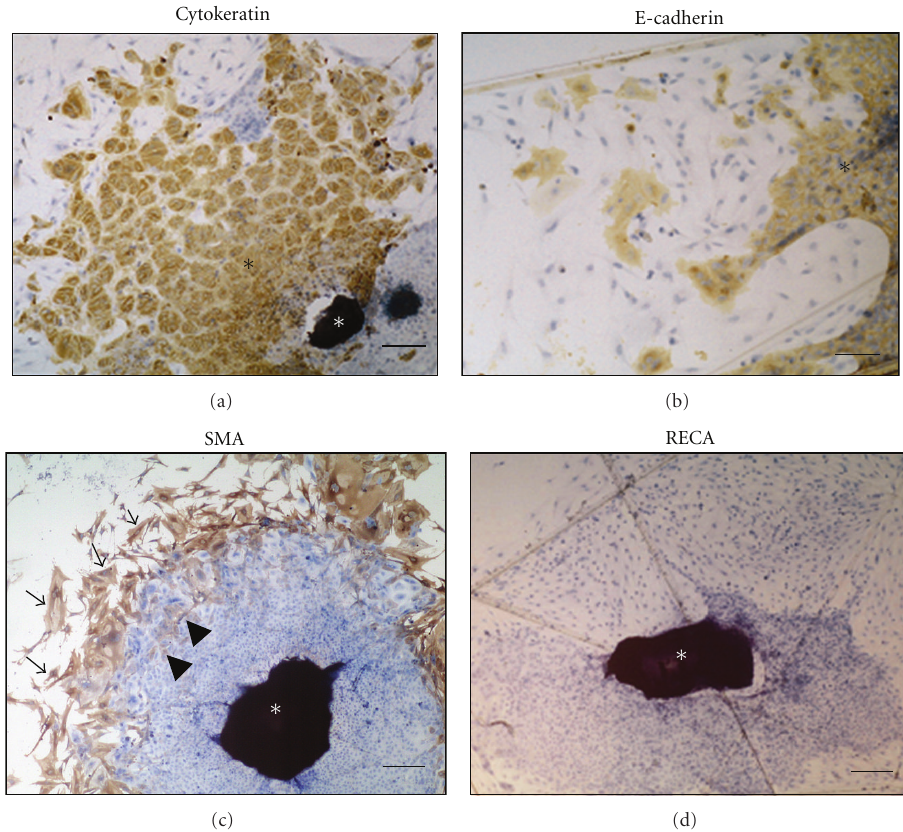
Figure 2: Immunohistochemical staining characteristics of cells 10 days after explanting. Two distinct areas are seen—an inner most area of cuboidal-shaped cells staining for (a) cytokeratin and (b) E-cadherin (black asterisk) and stellate-shaped cells at the periphery staining for (c) the myofibroblast marker SMA. Occasional cells at the junction of the two areas stain for SMA (arrow heads). (d) All cells were negative for the endothelial marker RECA. Remnants of the tissue explant from which cells have propagated can be seen (white asterisk). Scale bar = 50 μ